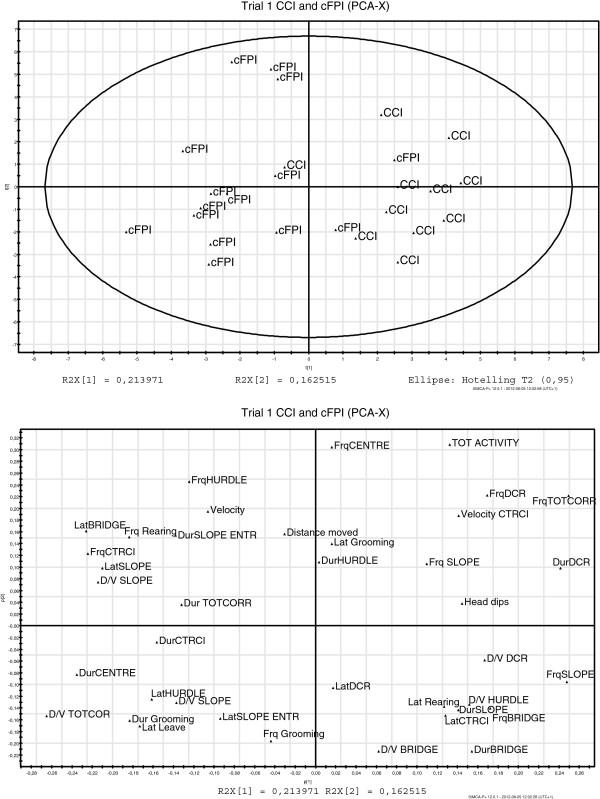
The principal component analysis (PCA) from the first MCSF test at 2 days post-injury. To test the hypothesis that the mouse cFPI model induces unique behavioral deficits compared to a focal traumatic brain injury (TBI) model, we extracted historical data [28] obtained under an identical set-up and by the same investigator. (A) PCA score plot showing a comparison between mice subjected to the controlled cortical impact (CCI, producing a focal TBI) model and the cFPI model, producing wide-spread traumatic axonal injury. The behavioral patterns of the two TBI models are markedly different; (B) PCA loading plot illustrating the MCSF variables that were included in the analysis. Variables located further away from the origin are most important for the model. CCI: Controlled cortical impact, n = 11 (from [28]); cFPI: Central fluid percussion injury, n= 15; CTRCI: Central circle; Dur: Duration; D/V: Duration per visit; Frq: Frequency; Lat: Latency; SLOPE E: Slope entrance; TOT ACTIVITY: Total activity in arena; TOTCORR: Total corridor entries.